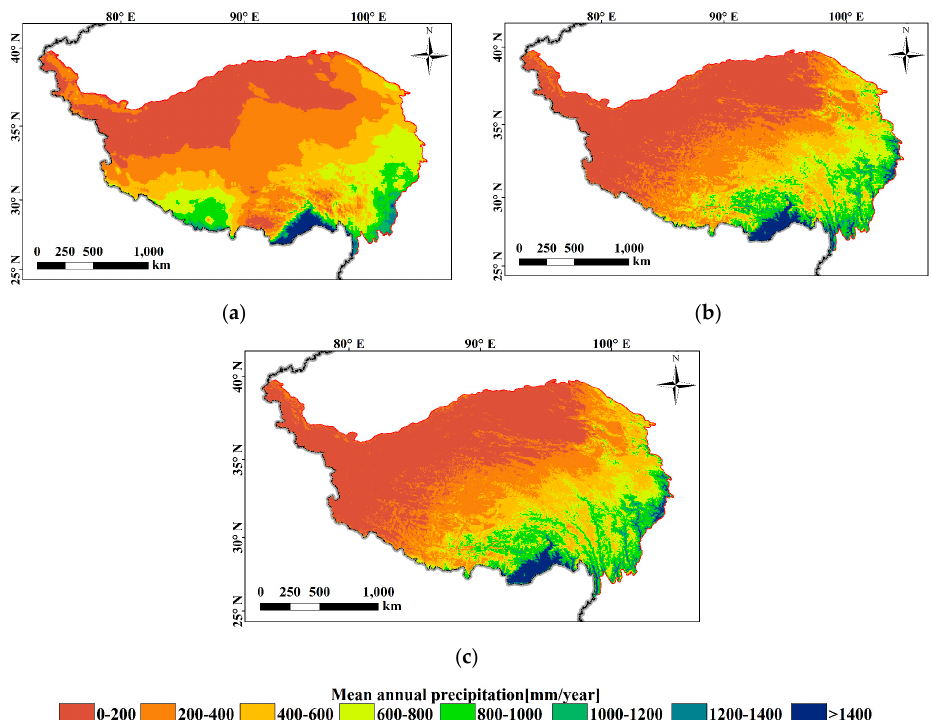
Figure 7. Spatial patterns of mean annual precipitation over the TP from 1990 to 1999 derived from ( a ) Climate Hazards group Infrared Precipitation with Stations (CHIRPS) at ~5 km resolution, ( b ) downscaled precipitation estimates (DS) without rain gauge calibration at ~1 km resolution, ( c ) DS with rain gauge calibration at ~1 km resolution. Remote Sens. 2018 , 10 , x FOR PEER REVIEW